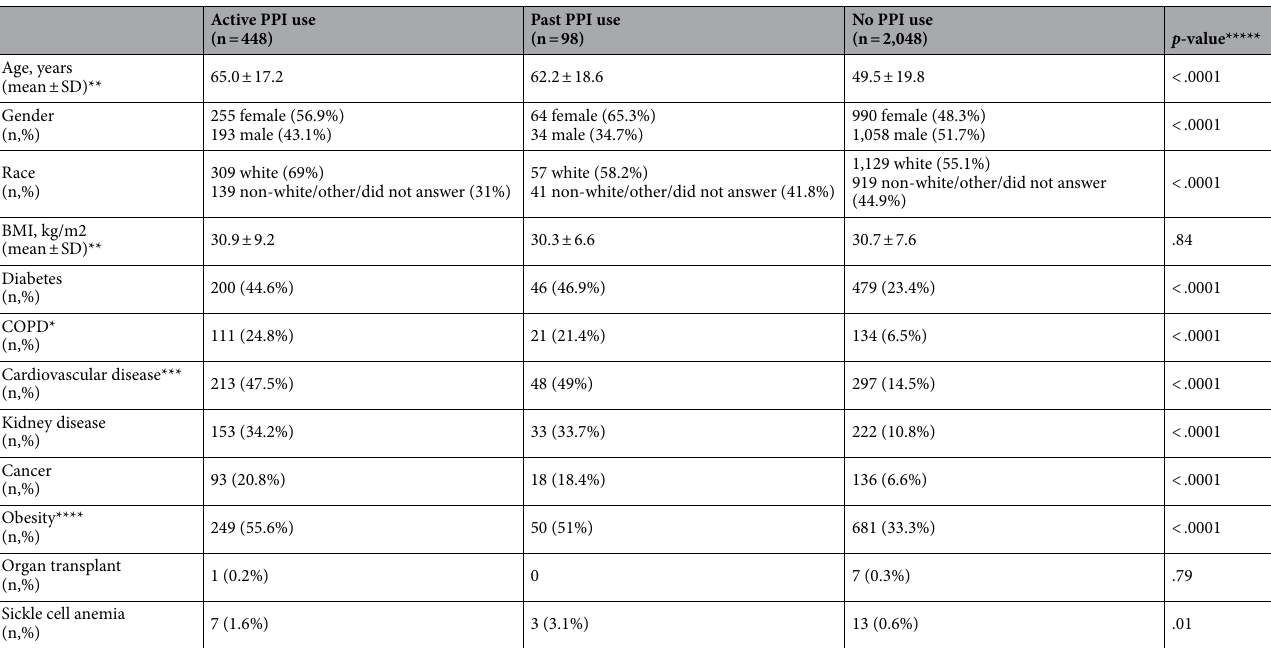
Table 1. Patient demographic and clinical variables*. *Denominators differ for some variables due to missing data. ** SD Standard deviation, COPD Chronic obstructive pulmonary disease. ***Cardiovascular disease is a composite of cardiomyopathy, congestive heart failure, and coronary artery disease. ****Defined as BMI > 30 kg/m2. *****Based on separate one-way analysis of variance or chi square tests, as appropriate.